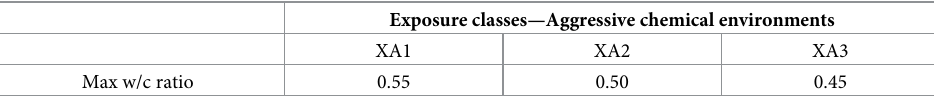
Table 2. Recommended limiting values for composition and properties of